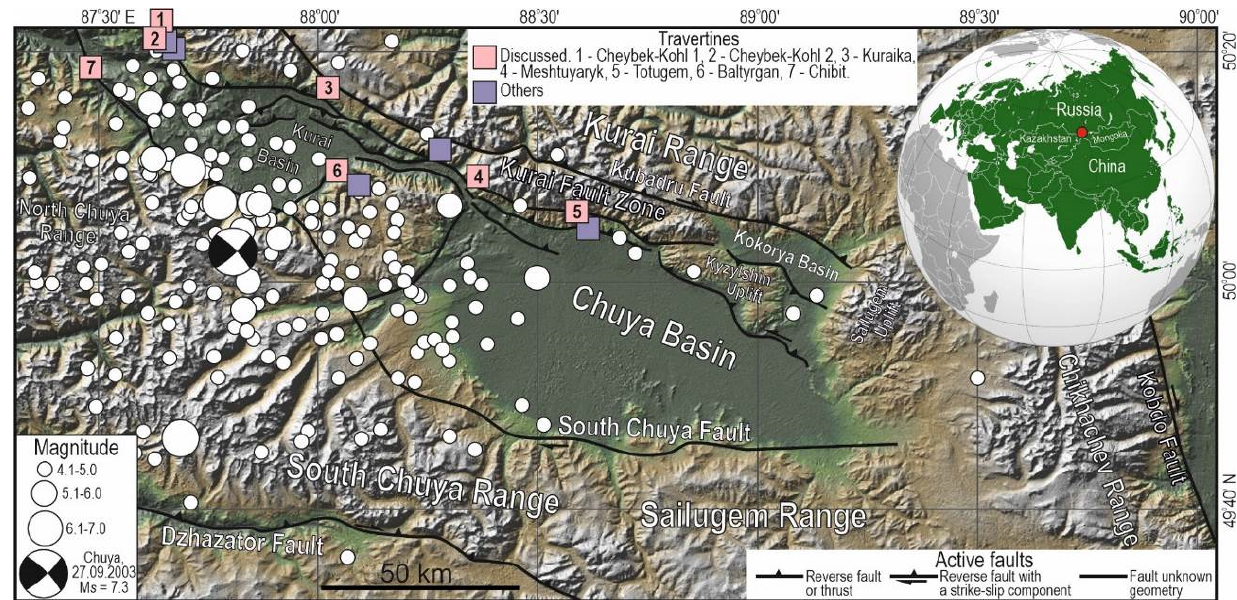
Figure 1. Main active faults, earthquakes, and travertines in the south-eastern Gorny Altai. Base map was made from GeoMapApp (http://www.geomapapp.org, accessed on 5 December 2022) [67].